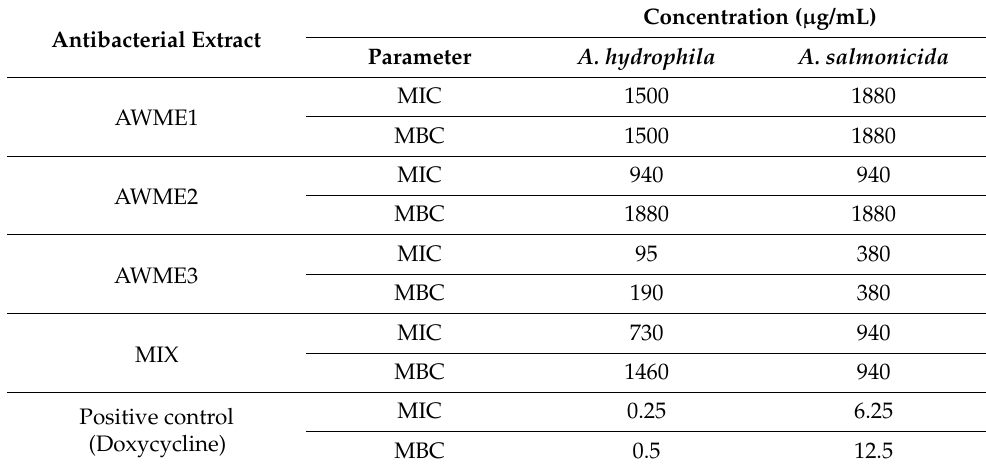
Table 2. MIC and MBC of SEs against fish pathogenic bacteria Aeromonas spp.